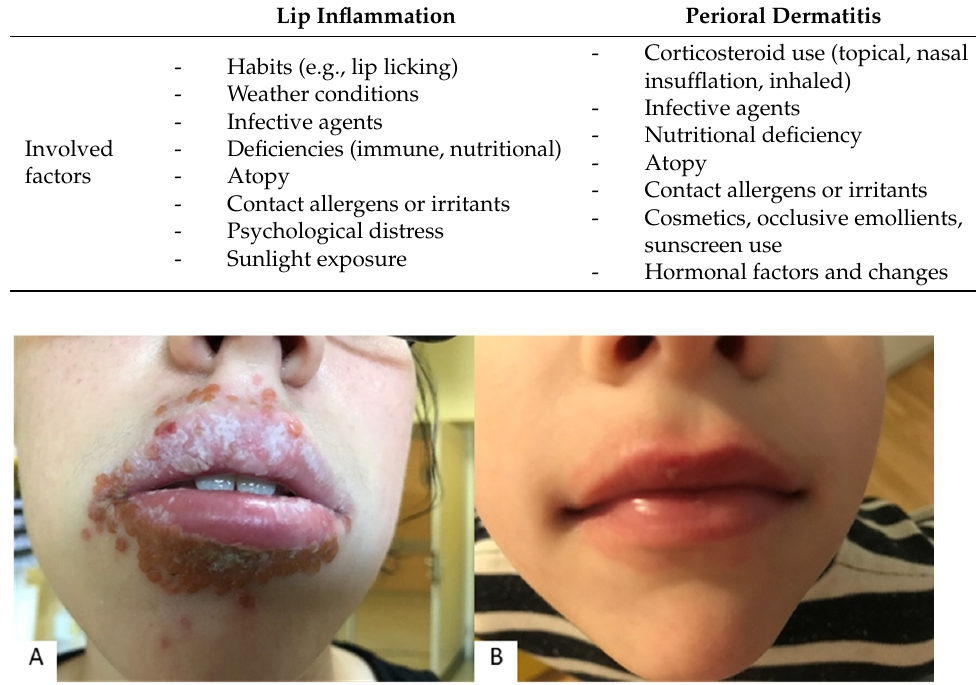
Figure 1. Herpetic cheilitis (extreme clinical picture) ( A ) and contact cheilitis (in a child) ( B ); (mainly reversible forms).